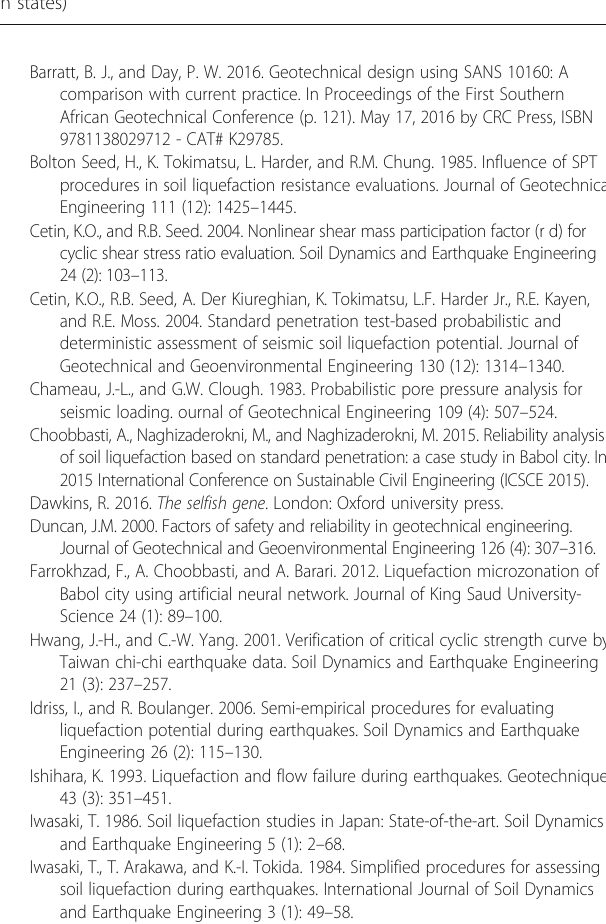
Fig. 11 Limit state (boundary between liquefaction and non-liquefaction